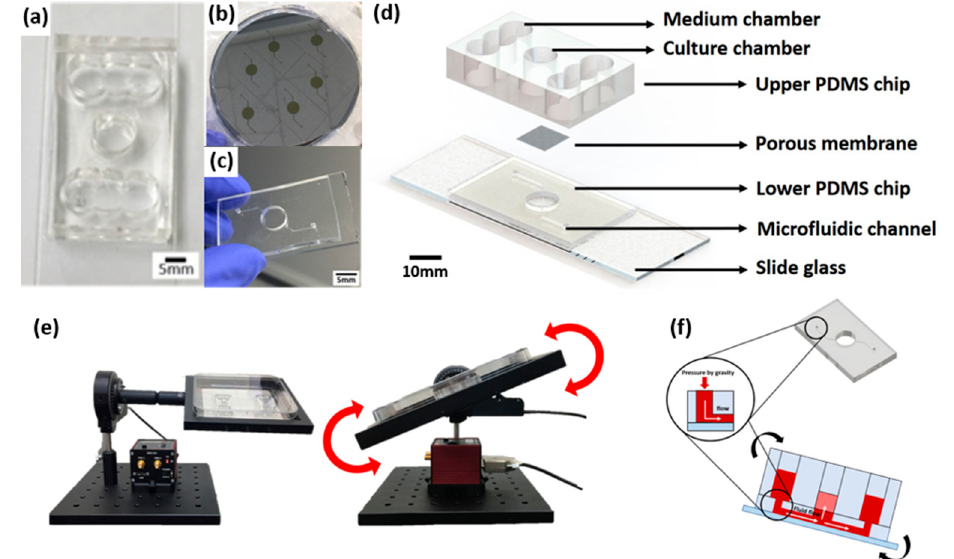
Figure 9. A schematic diagram of a microfluidic skin-on-a-chip before assembly and a gravity flow system. ( a ) Upper PDMS chip. ( b ) Microfluidic channels patterned mask mold. ( c ) The lower chip with the microfluidic channel patterned. ( d ) Configuration diagram of pumpless microfluidic skin-on-a-chip. ( e ) View of the front and side of the gravity flow system. It works by shaking both sides at 15 ◦ degrees. A 15 ◦ degree tilt causes the medium to circulate through the microfluidic channel. ( f ) A schematic diagram of a microfluidic skin-on-a-chip before assembly.